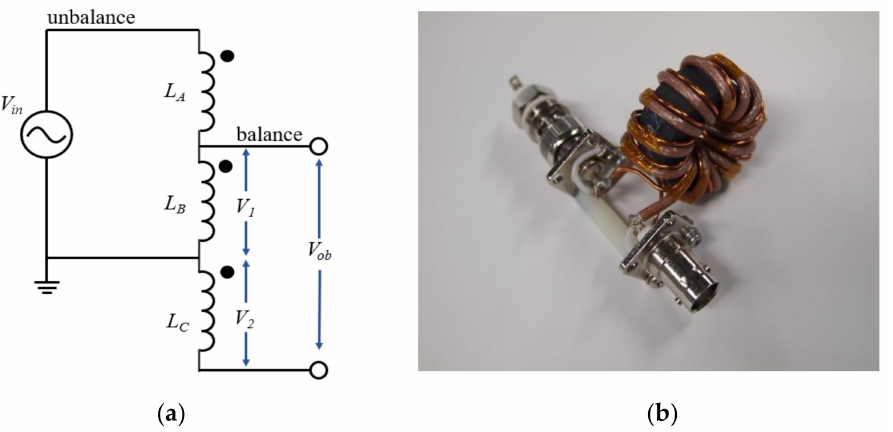
Figure 14. Ruthroff balun. ( a ) Circuit diagram. ( b ) Balun fabrication.